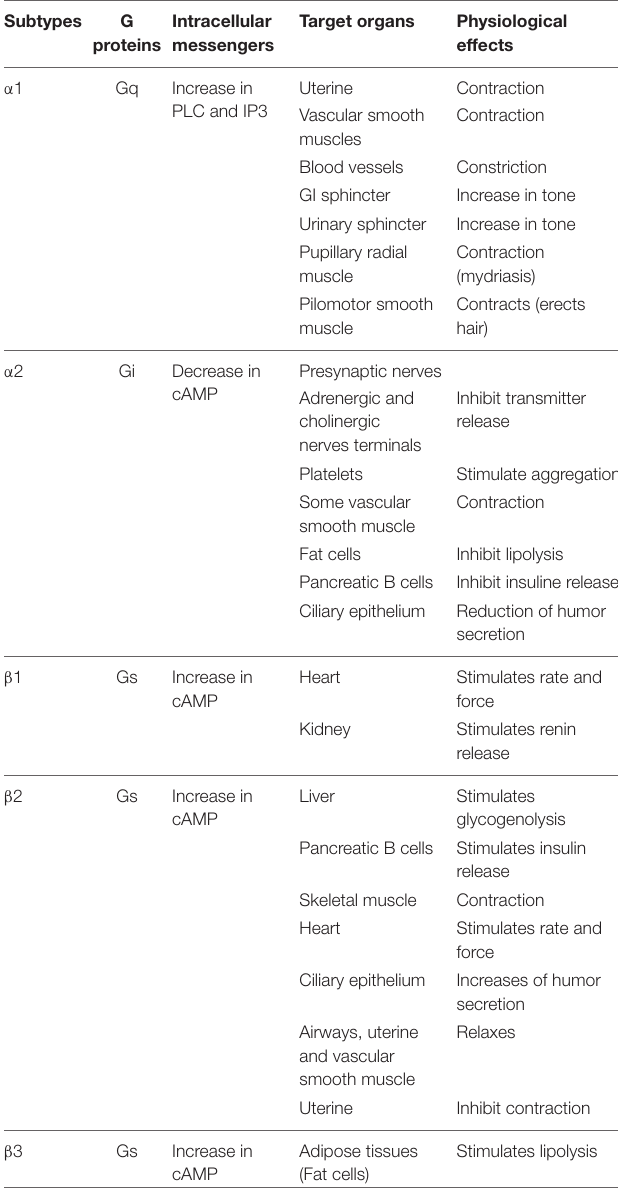
TABLE 1 | Adrenergic receptors and physiological